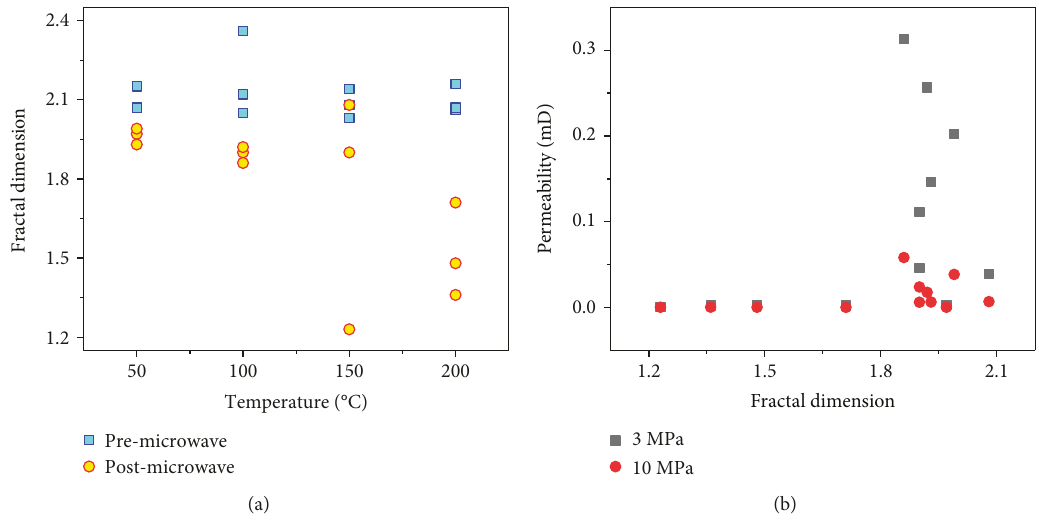
Figure 13: (a) Fractal dimension vs. processing temperature and (b) fractal dimension vs.